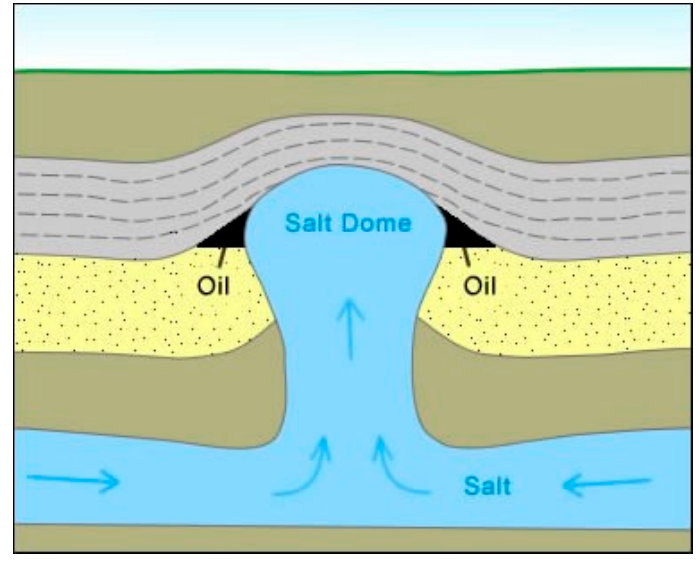
Figure 2. An illustration of a salt dome that is trapping oil (source: geology.com).